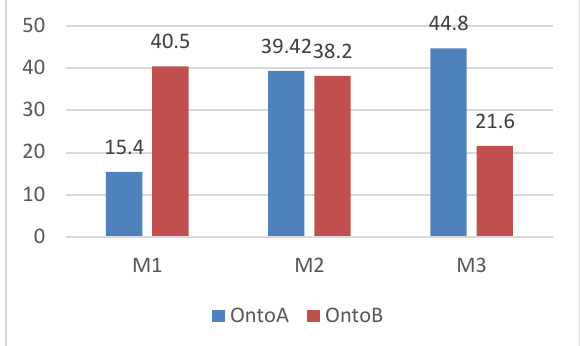
Figure 2. Percentage of Questions with Different Matching